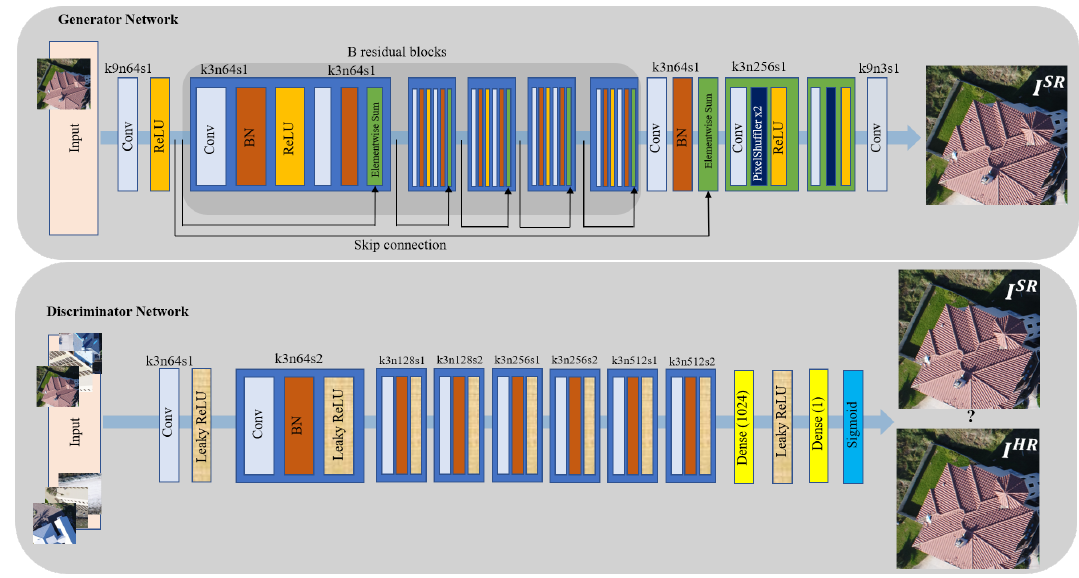
Figure 3. Architecture of Generator and Discriminator Network for SISR task with corresponding kernel size ( k ), number of feature maps ( n ), and stride ( s ) indicated for each convolutional